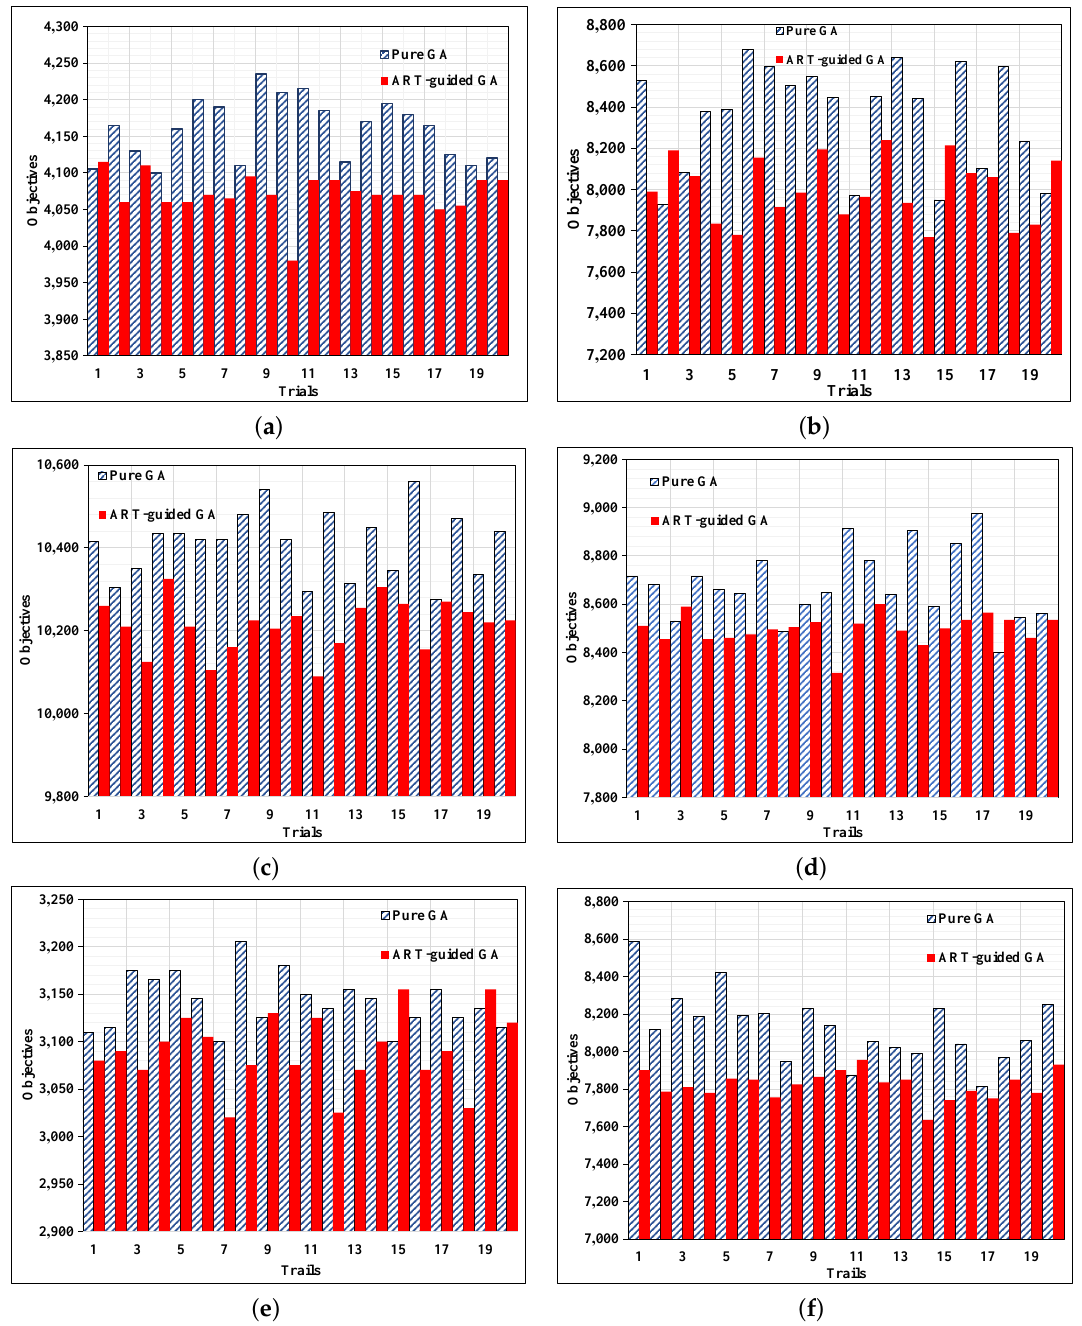
Figure 11. Comparison between GA and ANN-guided GA for problems 1 to 6 detailed in Table 7. ( a ) Problem-1. ( b ) Problem-2. ( c ) Problem-1. ( d ) Problem-2. ( e ) Problem-1. ( f )